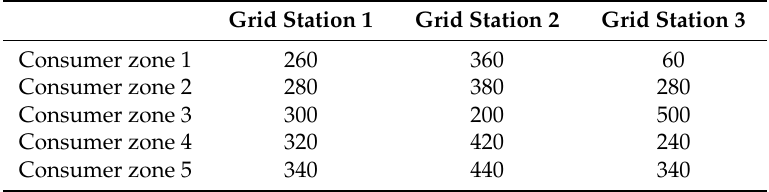
Table 5. Length of power transmission lines between grid stations and consumer zones (km).